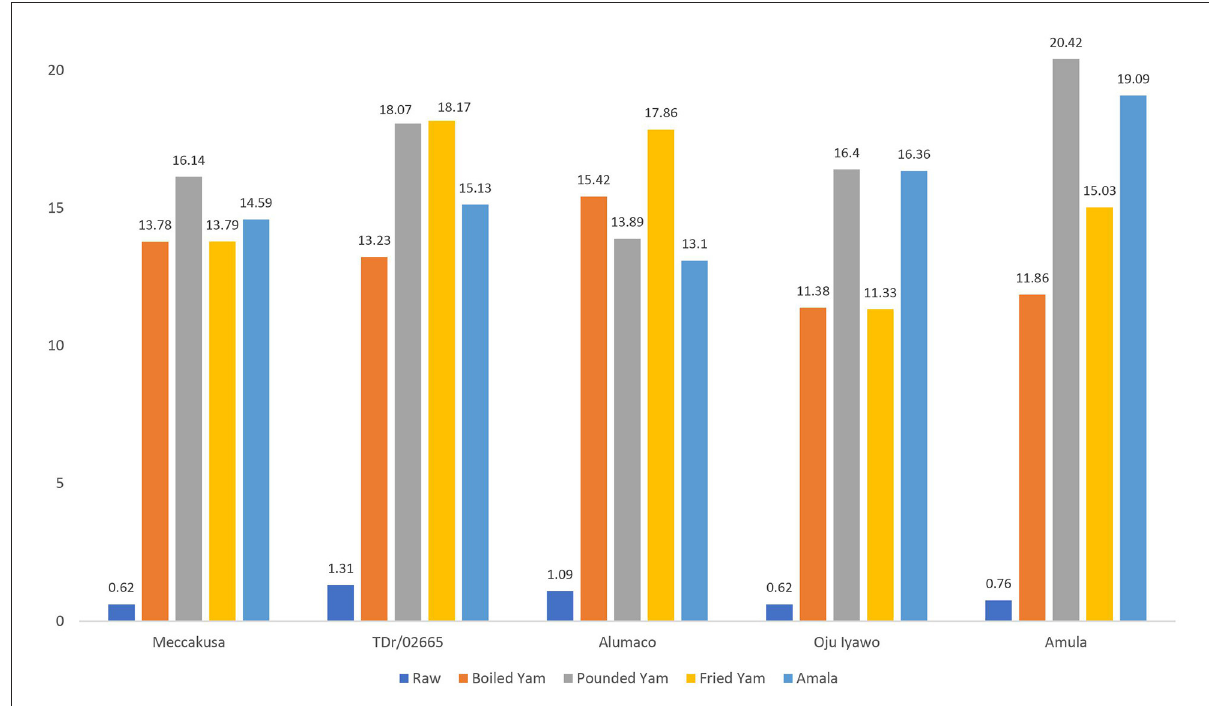
FIGURE1 Digestible Starch of raw tuber and products from five selected yam